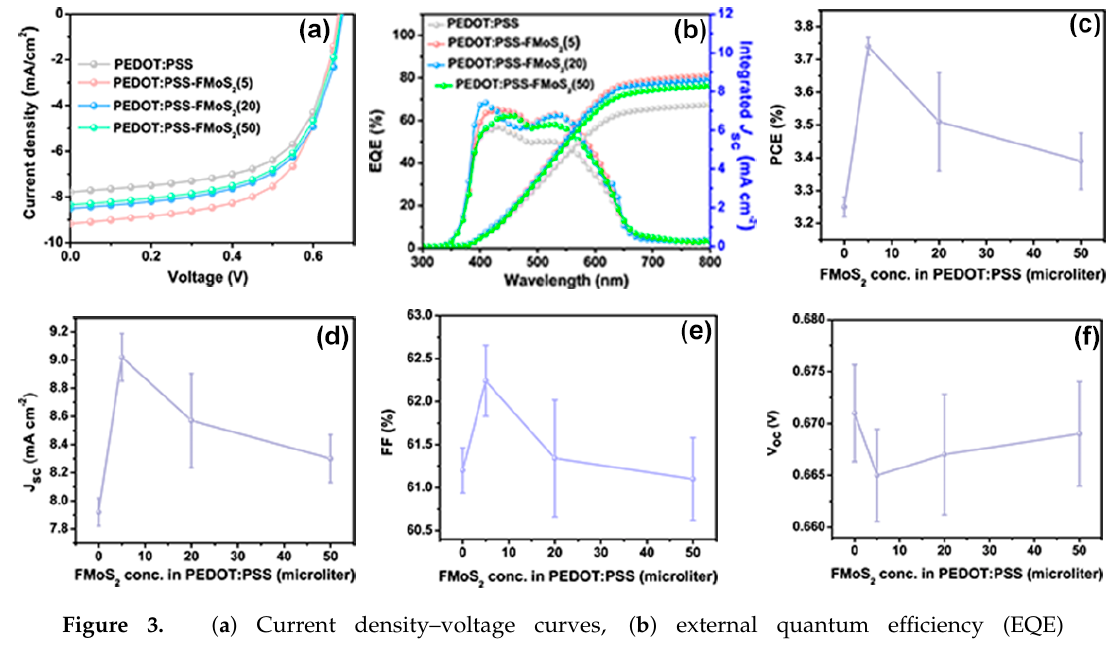
Figure 3. ( a ) Current density–voltage curves, ( b ) external quantum efficiency (EQE) profiles, ( c ) power conversion efficiencies (PCE), ( d ) short-circuit current density (J sc ), ( e ) fill factor, and ( f ) open-circuit voltage (V oc ) values of organic solar cells based on poly(3,4-ethylenedioxythiophene):poly(styrenesulfonate) (PEDOT:PSS) and PEDOT:PSS / oleylamine-functionalized MoS 2 (FMoS 2 ) as hole-transporting layers. The reported average PCE values are extracted from nine identical cells for each sample. Table 1. Photovoltaic performance of poly(3-hexylthiophene):[6,6]-phenyl-C61-butyric acid methyl ester-based organic solar cells having poly(3,4-ethylenedioxythiophene):poly(styrenesulfonate) (PEDOT:PSSS) and PEDOT:PSS / oleylamine-functionalized MoS 2 (FMoS 2 ) as hole-transportation layers.